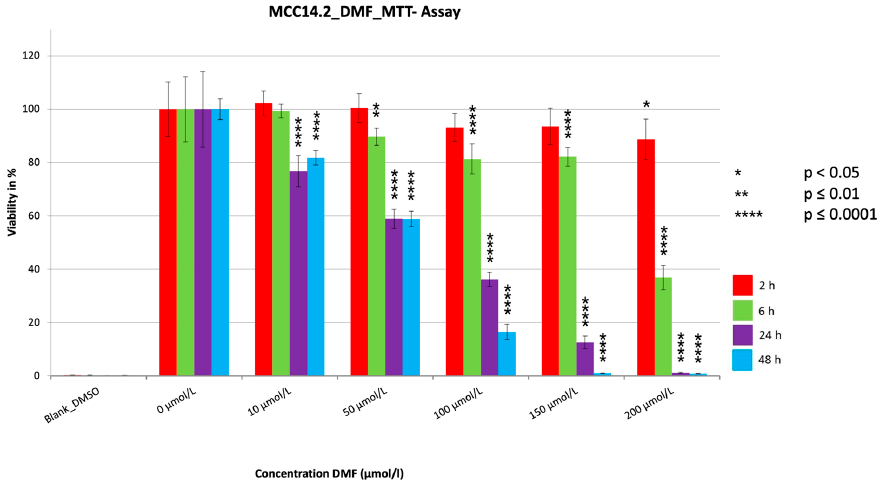
Figure 2. MTT measurement of the cell line MCC14.2 with a cell concentration of 20.000 cells/well with the addition of the substance DMF in different concentrations (10–200 µmol/L). Values are expressed as mean ± SD of eight technical replicates. A multiple comparison test following the ANOVA was used to test whether there were significant differences between the individual mean values and the mean value of the normal control.